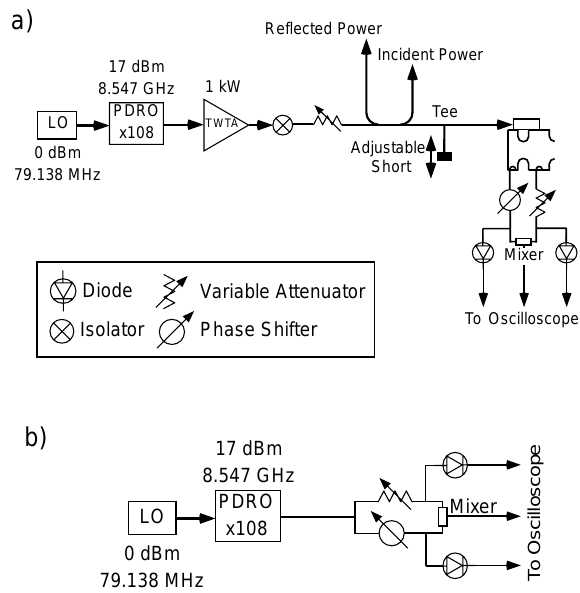
FIG. 4. Schematic of (a) the interferometer setup used to check the relative phases of the half and full cells of the gun, and (b) the setup used to calibrate the